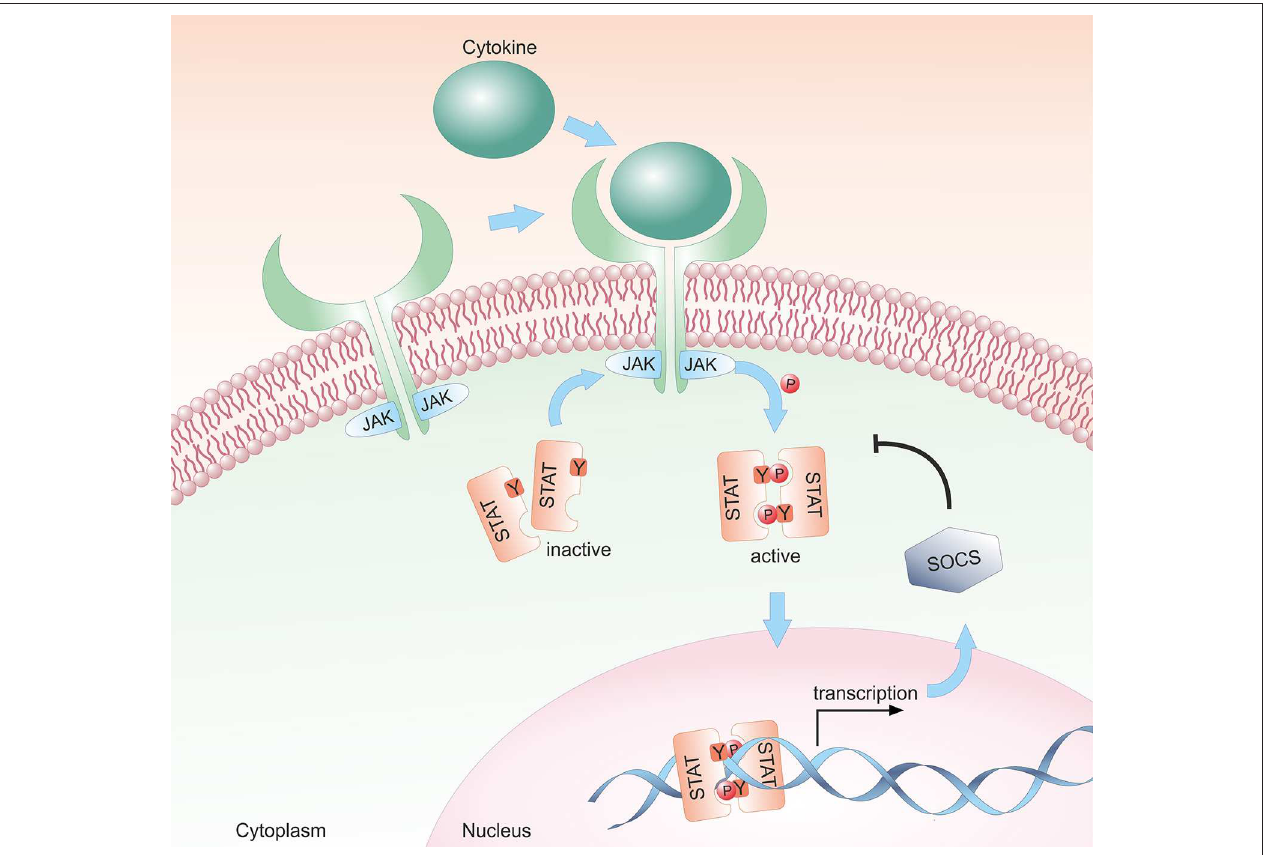
FIGURE 1 | Schematic representation of the canonical JAK/STAT signaling pathway. The JAK/STAT pathway transmits extracellular cytokine signals to the nucleus. Upon binding of a cytokine to its transmembrane receptor, receptor-associated JAKs are activated and phosphorylate STAT proteins. Activated STAT proteins translocate as either homo- or hetero-dimers to the nucleus and modulate target gene transcription. In a negative feedback loop, SOCS proteins are expressed and inhibit the JAK/STAT signaling cascade by suppressing JAK kinase activity, by competing with STAT proteins for binding to the receptor and/or by proteasomal degradation of the